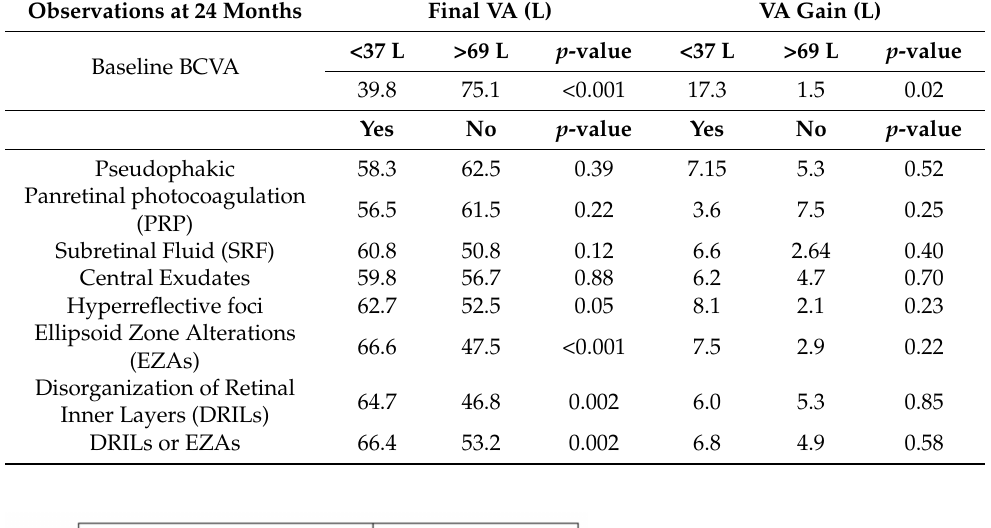
Table 3. Anatomical prognosis factor for final visual acuity (VA) and VA gain at 24 months. (BCVA = best-corrected visual acuity; CSMT = central subfield macular thickness; HIP = high intraoc- ular pressure; HBP = high blood pressure; PRP = panretinal photocoagulation; SRF = subretinal fluid; EZAs = ellipsoid zone alterations; DRILs = disorganization of retinal inner layers). Observations at 24 Months